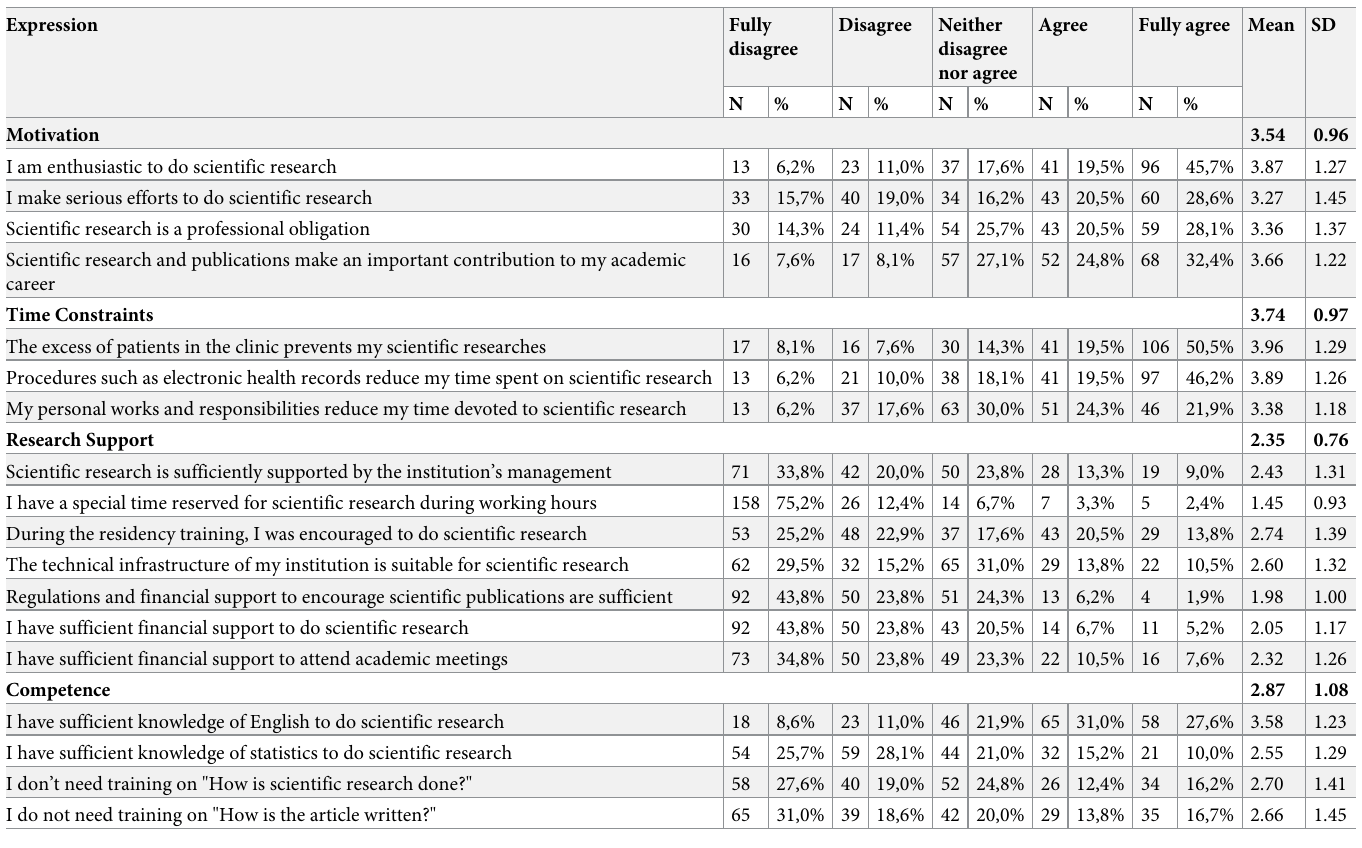
Table 2. Frequency distribution of the research barriers scale of ophthalmologists.